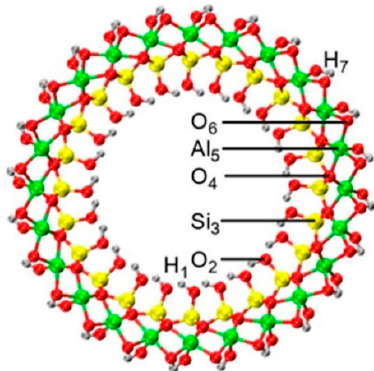
Figure 2. The atomic structure of the AlSi NT (N = 24) with the labeling used for the atomic radial layers.